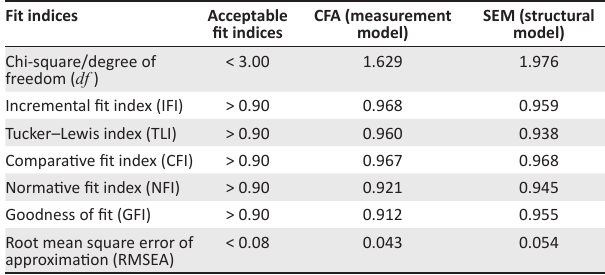
TABLE 4: Model fit statistics. FIGURE 5: